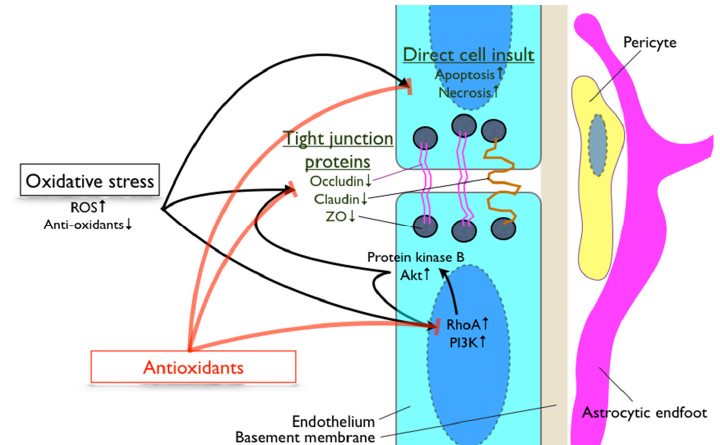
Figure 1. Involvement of oxidative stress in blood ‐ brain barrier regulation. The diagram summarizes the oxidative stress pathways that are involved in the regulation of blood ‐ brain barrier integrity. PI3K: phosphoinositide 3 ‐ kinase; RhoA: ras homolog gene family member A; ROS: reactive oxygen species; ZO: zonnula